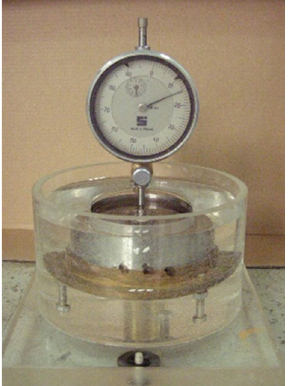
Figure 2. One-dimensional oedometer swell test in distilled